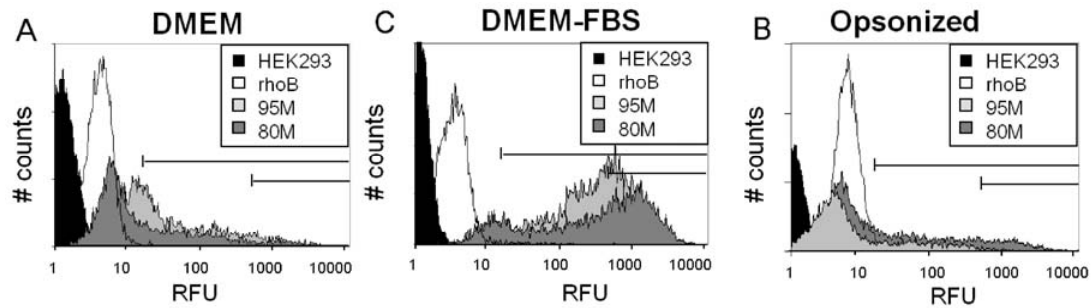
Figure 9. Flow cytometry profiles of cells exposed for 24 h to RITC-chitosan microparticles in DMEM ( A ), in DMEM+10% FBS ( B ), or FBS-opsonized RITC-chitosan microparticles in DMEM ( C ). All media was pH 7.4. White peak: free rhodamine B; black peak: unlabeled HEK293 cells; light grey peak: RITC-95M; dark grey peak: RITC-80M.